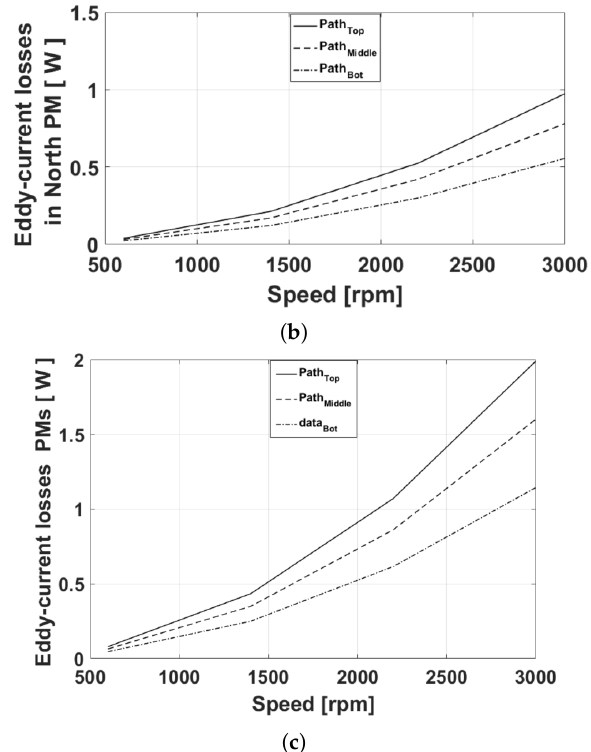
Figure 21. Non-uniform volume repartition of the eddy current losses vs. speed for different paths: ( a ) South PMs, ( b ) North PMs, and ( c )